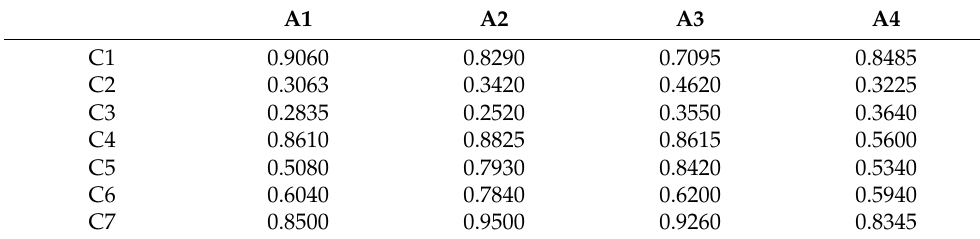
Table 4. Decision matrix for selecting third-party logistics providers.